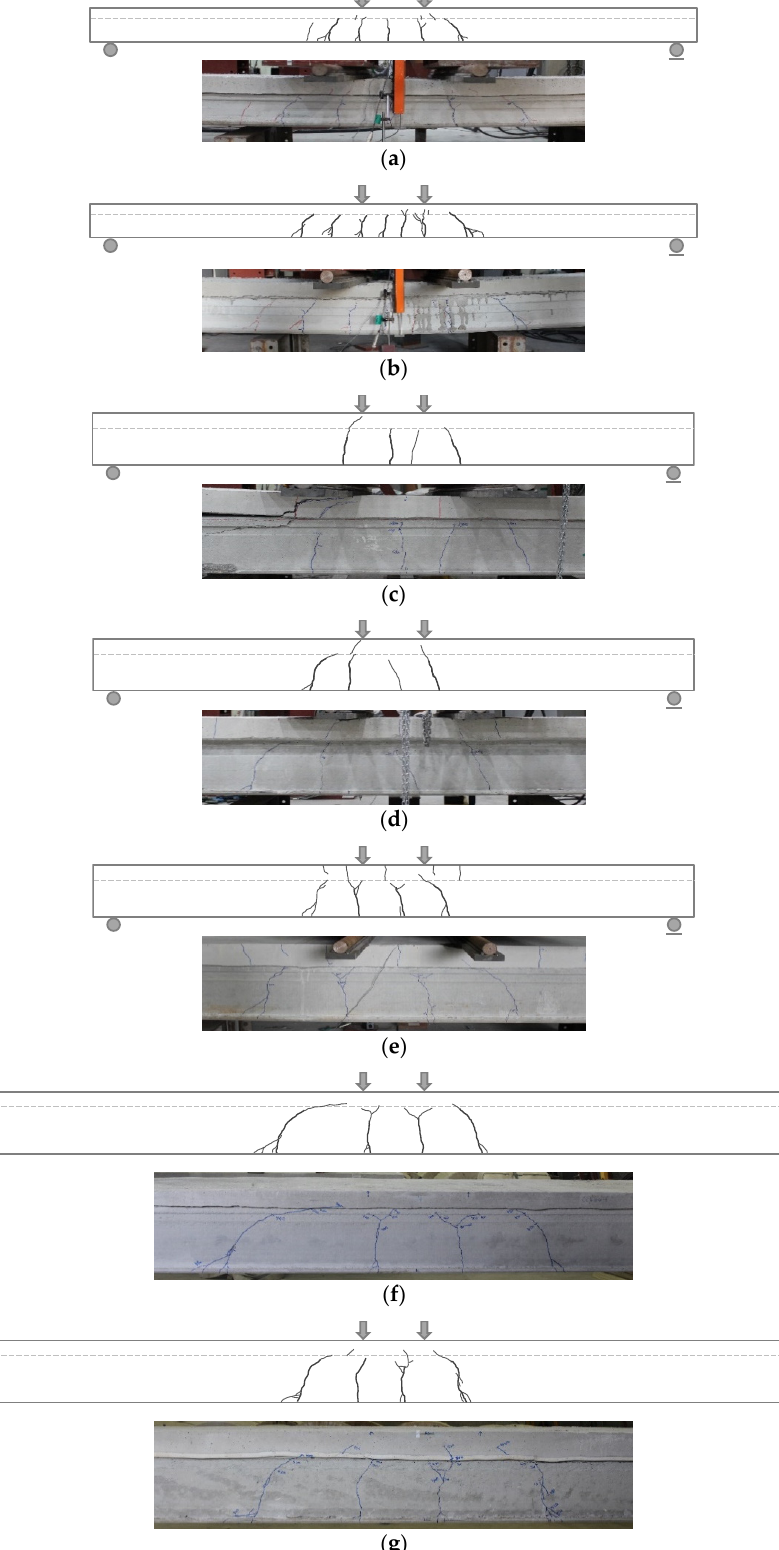
Figure 10. Crack patterns of specimens at peak load: ( a ) CF200-1; ( b ) CN200-1; ( c ) CF320-3; ( d ) CC320-3; ( e ) CN320-3; ( f ) CF400-1; ( g ) CN400-1. The photographs were the crack patterns of speci- mens at the end of the